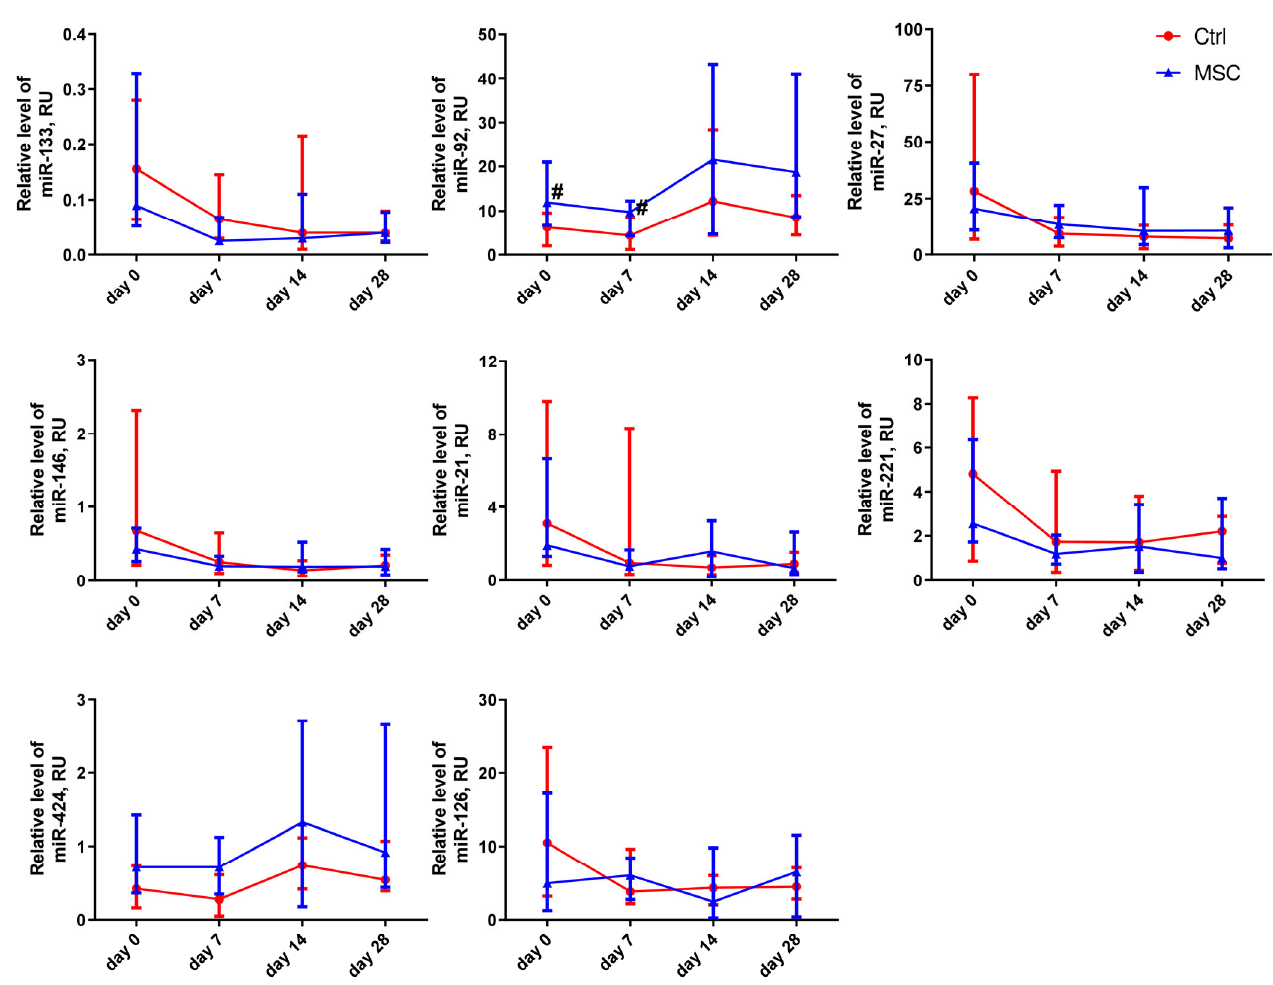
Figure 4. Dynamic changes in miRNAs’ expression levels in patients with COVID-19. Data are presented as a median and IQR. Mann–Whitney U test for comparing the control and MSC groups at each time-point: #, p ≤ 0.05. The red line represents the Control group; the blue line represents the MSC group.